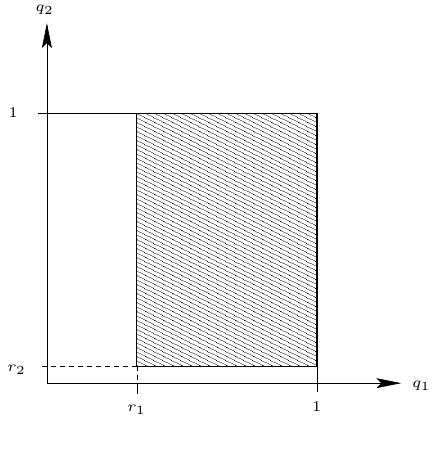
Figure 7. The region in which Ally-Ally is a Nash equilibrium when Player II makes a unilateral commitment to improved market performance.